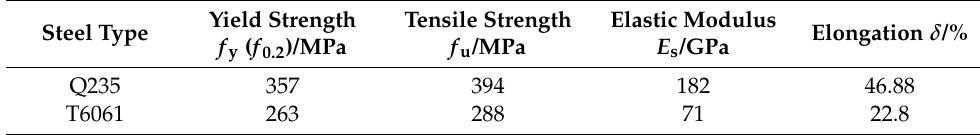
Table 2. Mechanical properties of the steel tubes.